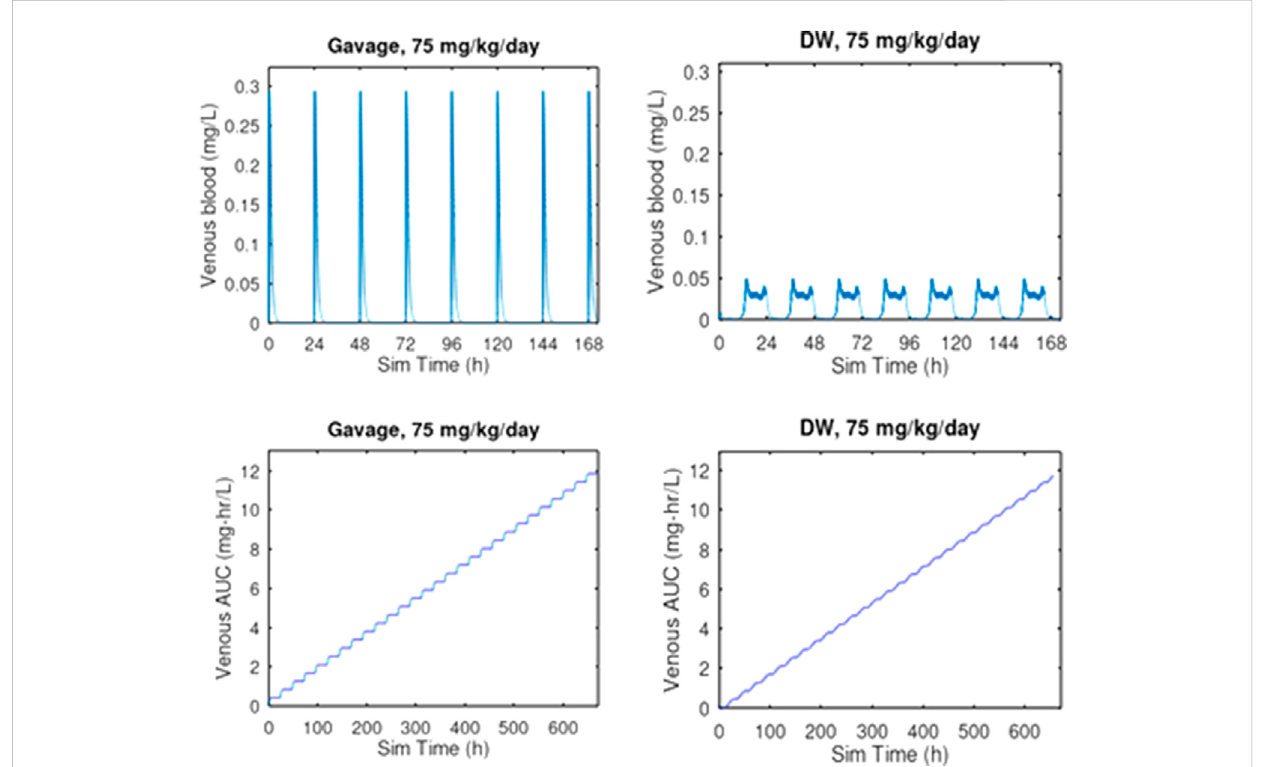
FIGURE 4 PBPK comparison of Cmax and AUC for oral gavage and drinking water exposure at 75 mg/kg/day for 28 days. Oral gavage dosing is predicted to result in a 5.9-fold greater venous blood concentration than the same daily dose given in drinking water. Given that this dose of 75 mg/kg/day was lethal to 2 of 10 rats by oral gavage after 2 days of exposure (Liberacki, 1999) while all 6 rats survived 29 days of exposure to 83.9 mg/kg/day by drinking water administration(Young,2020),theseresultssuggestthattheconsiderablyhigherCmaxassociatedwithoralgavagedosingisakeydeterminantofthe toxicity of